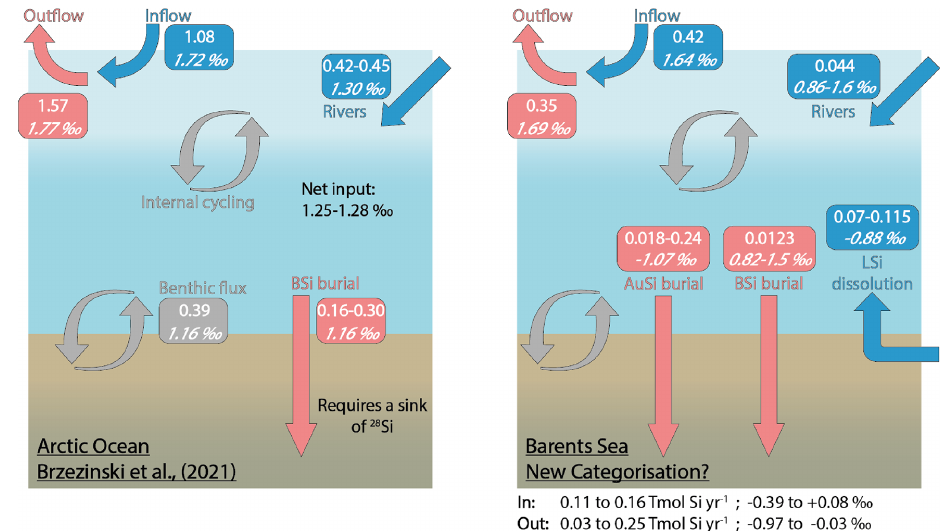
Figure 6. The Arctic Ocean Si budget (Brzezinski et al., 2021) (left) and a proposed Si budget for the Barents Sea (right), including a benthic flux recategorisation (i.e. contributions from BSi and LSi) and AuSi burial. Boxes include flux magnitudes given in TmolSiyr − 1 (top values) and the flux δ 30 Si in per mille (‰; italicised bottom values). “In” and “Out” refer to the Si fluxes, discounting the water mass inflow and outflow (i.e. in (blue) includes rivers + LSi; out (red) includes AuSi + BSi). Grey boxes and arrows represent internal cycling. See Supplement Sect. 3 for further information on how the Barents Sea Si budget was